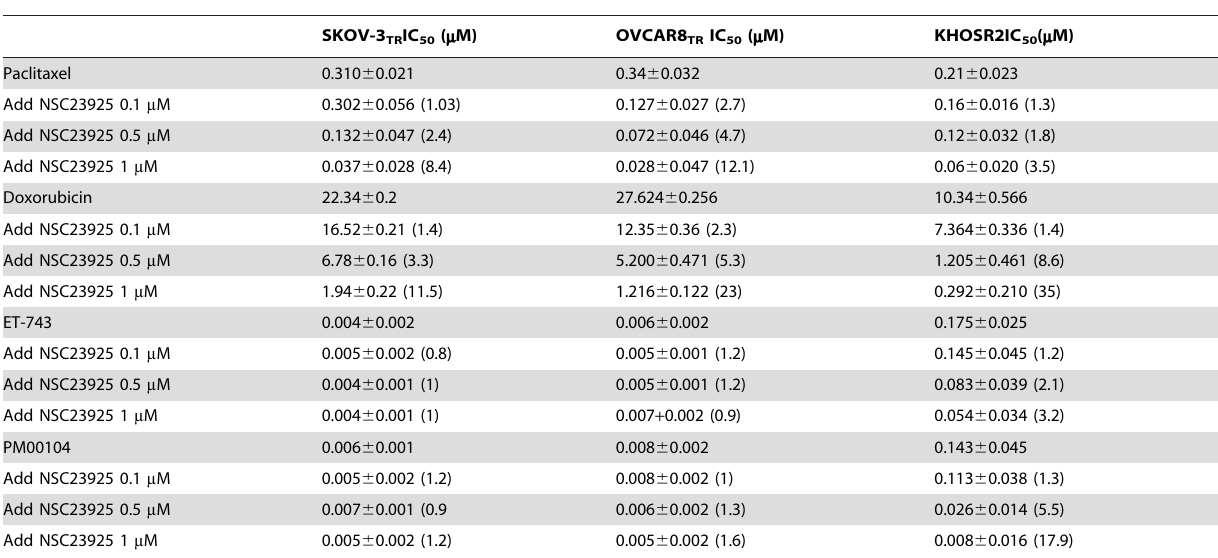
Table 1. Effect of NSC23925 Reversing Drug Resistance in Multidrug Resistant Cell